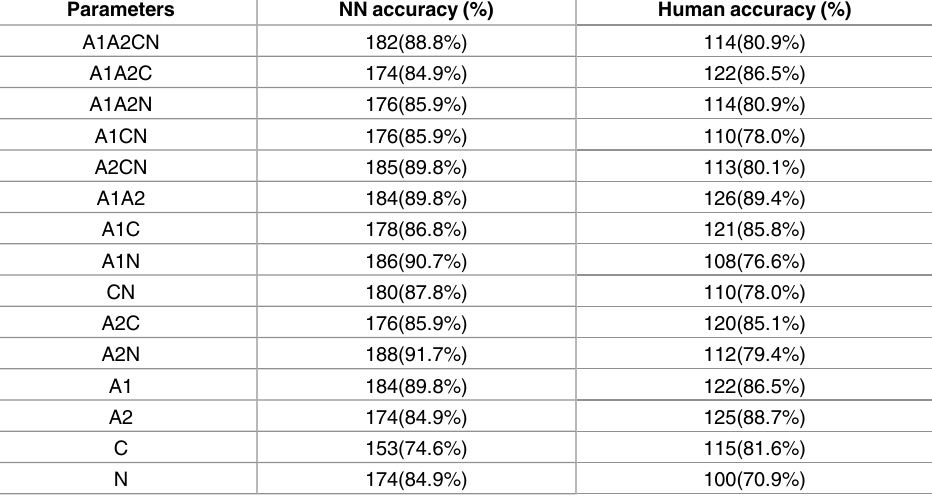
Table 3. Accuracy comparison of the NN for 205 nodes and expert evaluation for 141 nodes for 15 combinations of four